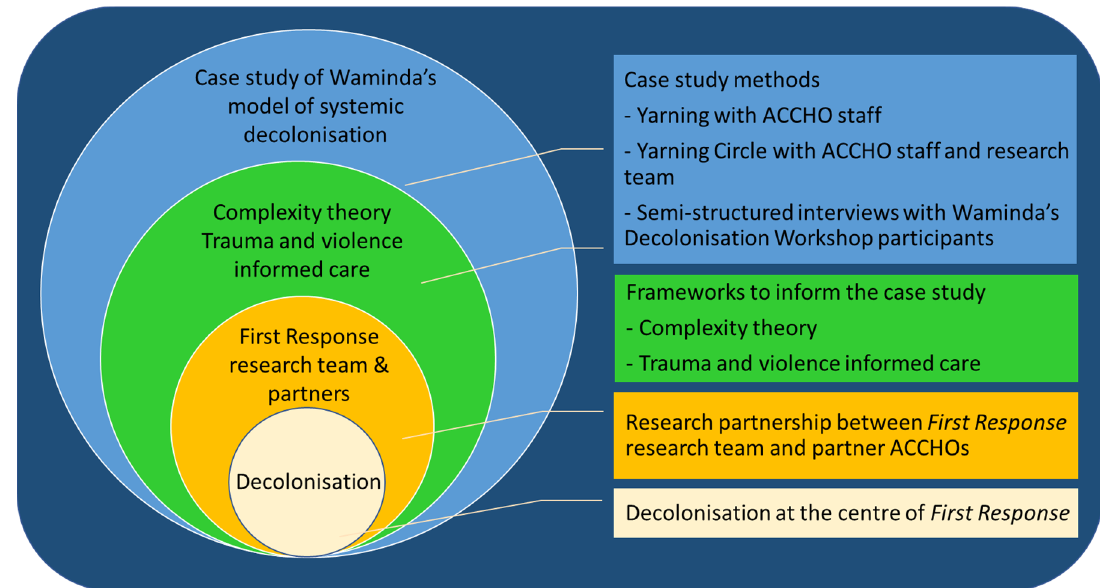
Figure 1. The case study is informed synergistically by complexity theory and trauma and violence informed care, which has been undertaken within the existing research partnership of the First Response project, in which decolonisation is central. The case study brings together yarning with staff from the partner Aboriginal Community Controlled Health Organisations (ACCHOs) and semi-structured interviews with the Decolonisation Workshop participants.